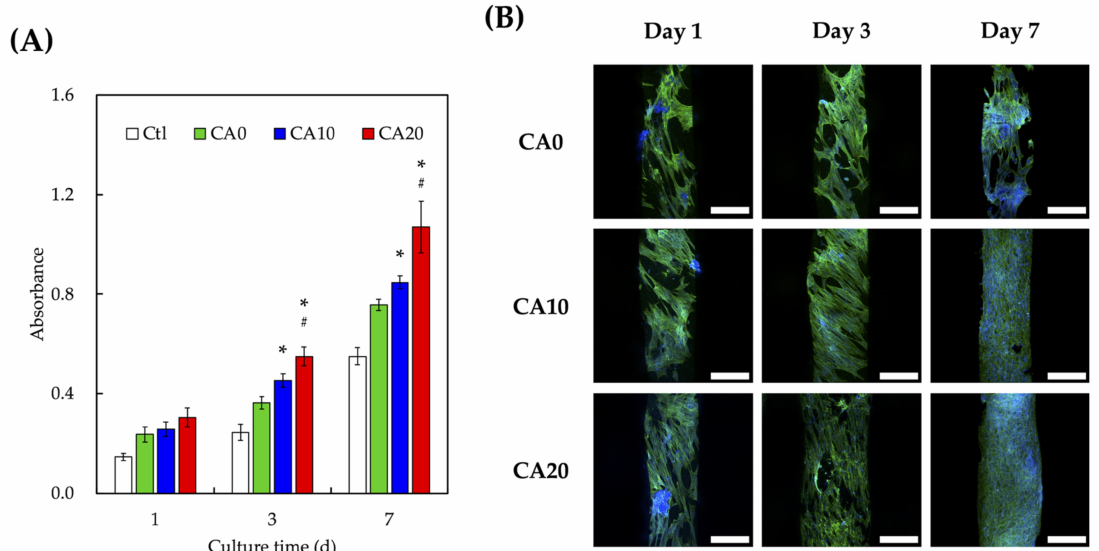
Figure 5. ( A ) Proliferation rate and ( B ) F-actin (green) and nuclei (blue) staining of hDPSCs cultured on different CA-coated MTA scaffolds for 1, 3, and 7 days. * indicates a significant difference ( p < 0.05) from CA0. # indicates a significant difference ( p < 0.05) from CA10. Data presented as mean ± SEM; n = 6 for each group. The scale bar is 200 µ